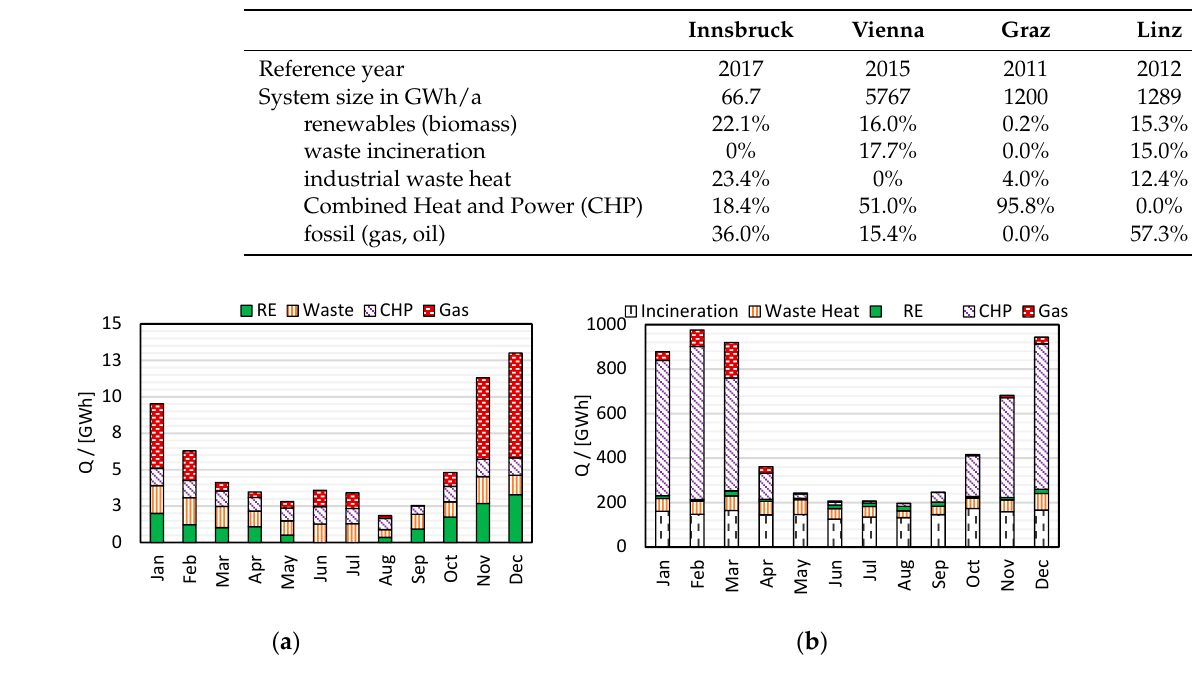
Table 1. Share of renewables in DH in %, examples from Austria, acc. to [13].